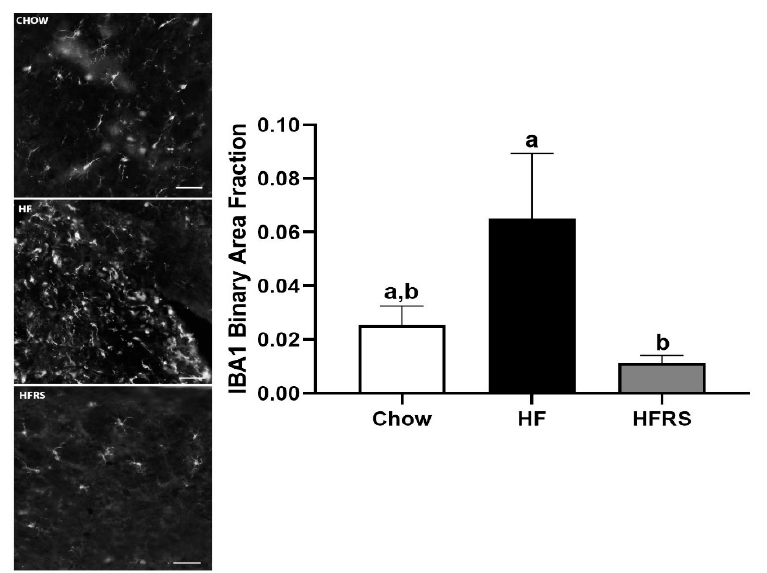
Figure 6. Fluorescent staining for IBA1 quantification showed a significant increase in positive staining in the NTS of HF-fed rats compared to HFRS animals ( right ). Representative images showing positive staining and morphology of microglia in chow, HF, and HFRS NTS sections ( left ). NTS = nucleus tractus solitarius, IBA1 = isolection B-alpha 1, HF = high fat, HFRS = high-fat resistant starch, a, b di ff erent letters indicate statically significant ( p < 0.05) di ff erences among groups, n = 6–7, scale bar = 50 µ m.